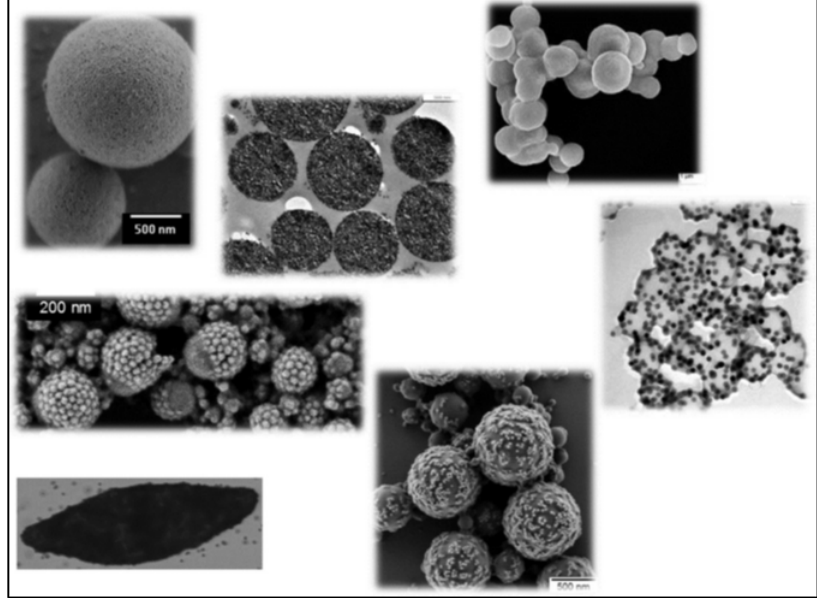
Figure 6. Nanostructured particles produced in dynamic high-pressure processes via miniemulsions. Reproduced with the permission from [11]; Woodhead Publishing, 2016.